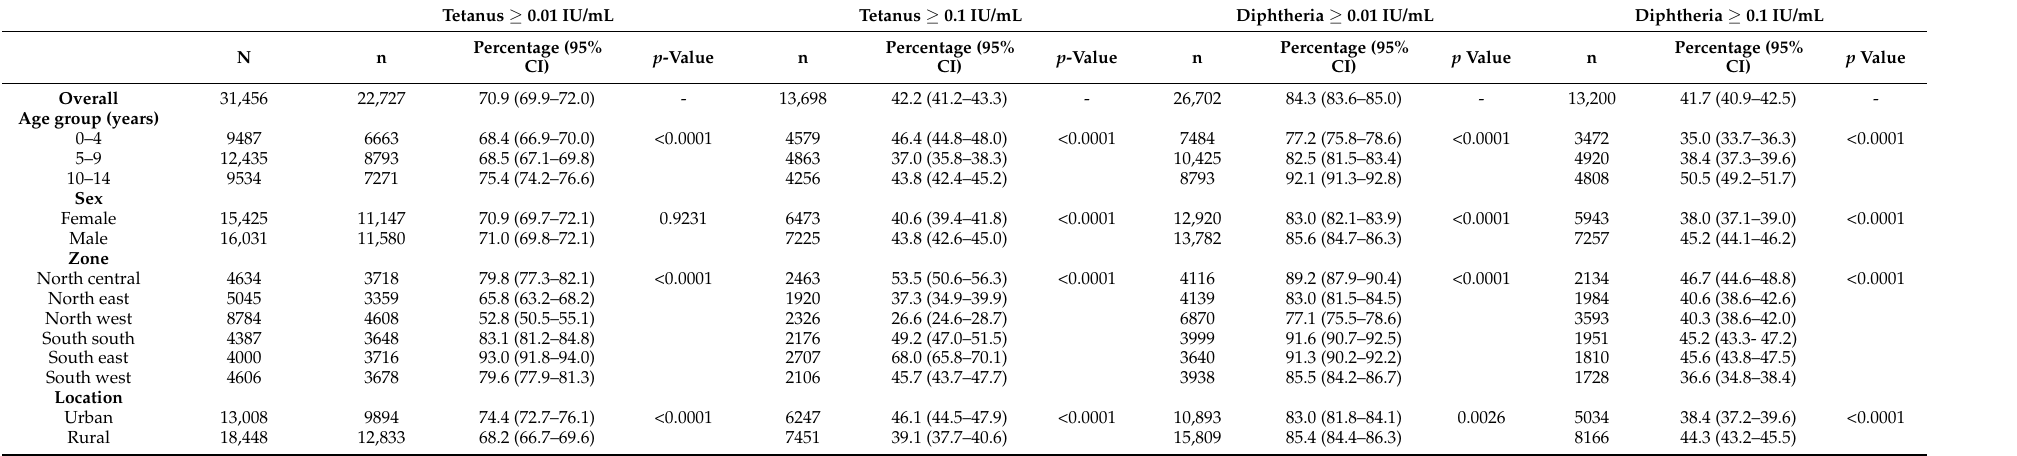
Table 2. Tetanus and diphtheria seroprotection among children aged <15 years, Nigeria,